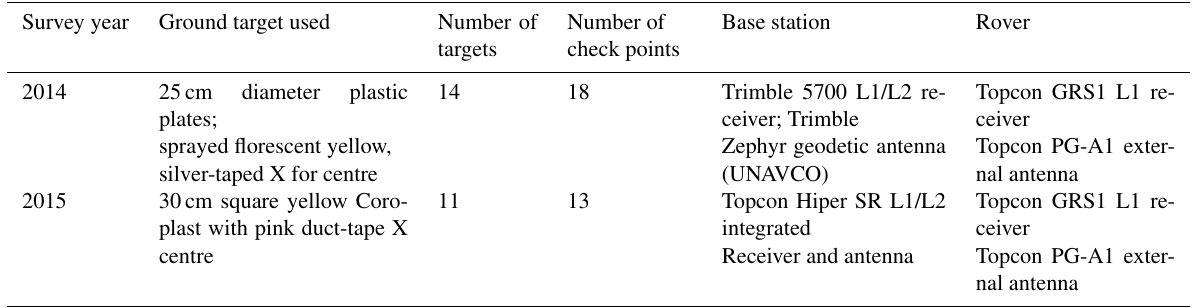
Table 1. Llaca Glacier GNSS ground control survey and hardware specifications.